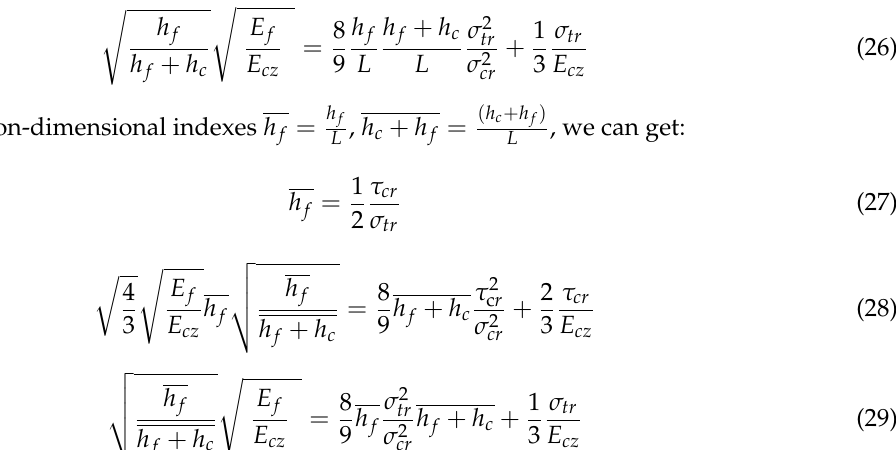
Figure 12. Photograph of indentation combined with face yield under three-point bending. 4. Conclusions A new type of Taiji honeycomb structure proposed in this paper has 3.5 times the compression strength and 3.44 times the shear strength of commercial hexagonal ones by treating the cell wall as an interconnected thin plate to calculate the stability capacity. Considering the density effect, the novel structure also has an increase in compression strength of 1.75 times and shear strength of 1.72 times. The reinforcement of the core also results in an almost linear increase to the whole strength of the sandwich composite. Both the experiment and theoretical methods were employed to investigate the deformation behavior and the failure mechanism for the sandwich beam with Taiji honeycomb core. The maximum resistance to central loading was improved significantly depending on the increasing skin or core thickness. Surface indentation and core shear failure played the dominant role under three-point bending test conditions. For a large skin thickness-span and beam thickness-span ratio, core shear failure occurred first; otherwise, indentation could occur prior to any core failure. However, typical face yield was not observed due to the limited thickness-span ratio of specimens.